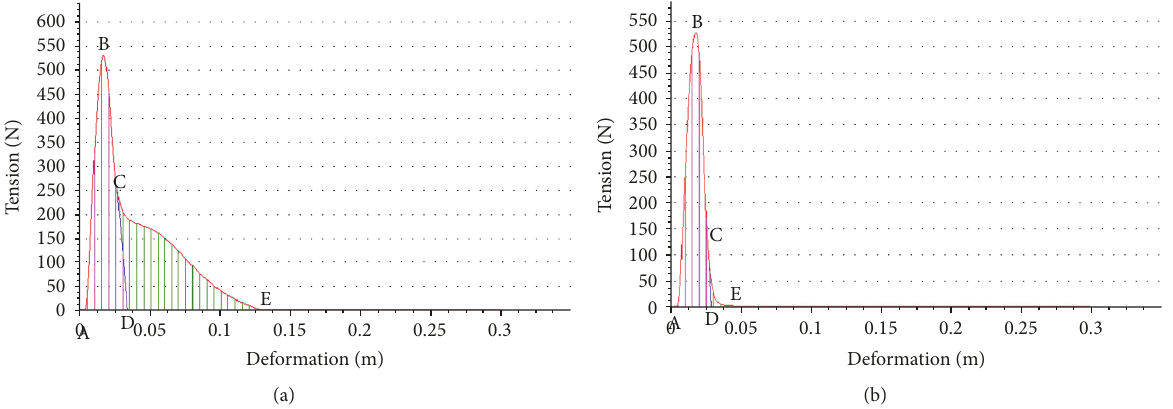
Figure 2: Tension-deformation curves of SBS modified asphalt and matrix